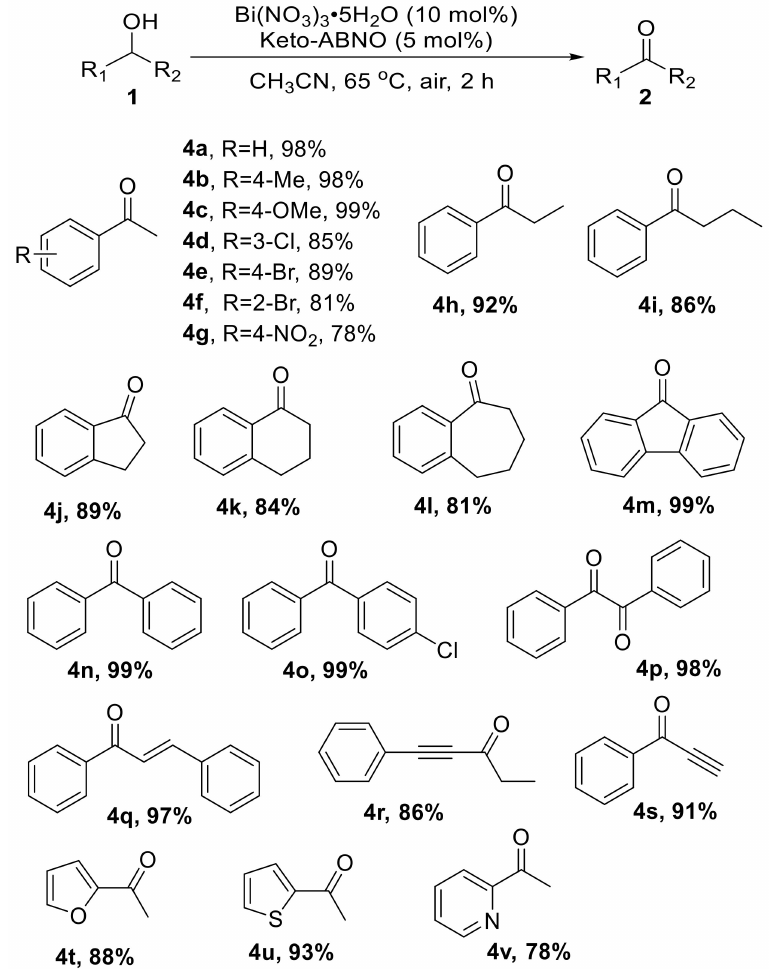
Scheme 3. Aerobic oxidation reaction of secondary alcohols to ketones. Reaction conditions: